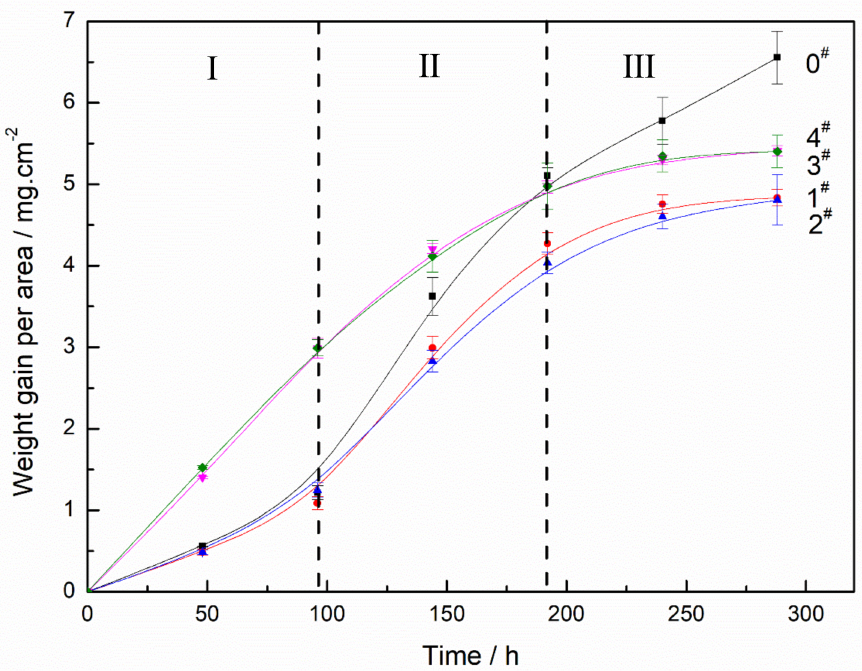
Figure 3. Corrosion behavior (weight gain per unit area in early (I), middle (II), and late (III) corrosion stage) of Cu-bearing